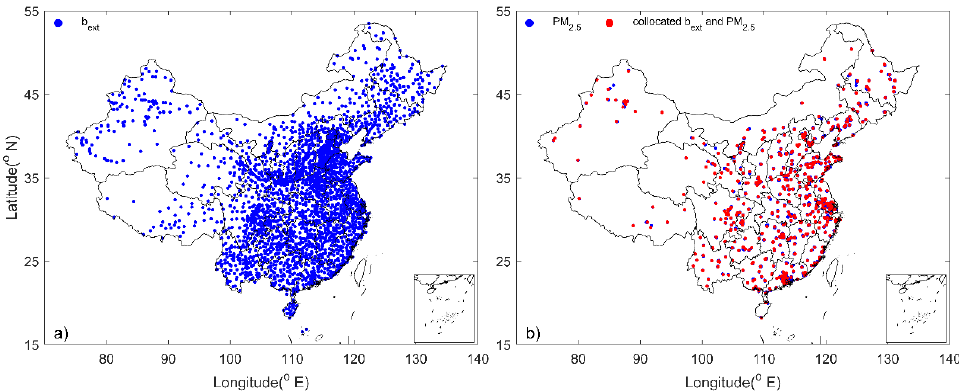
Figure 1. The spatial distribution of the visibility (b ext ) stations ( a ), PM 2.5 stations (blue dots in ( b )), and collocated b ext and PM 2.5 stations (red dots in ( b and collocated b ext and PM 2.5 stations (red dots in ( b )).